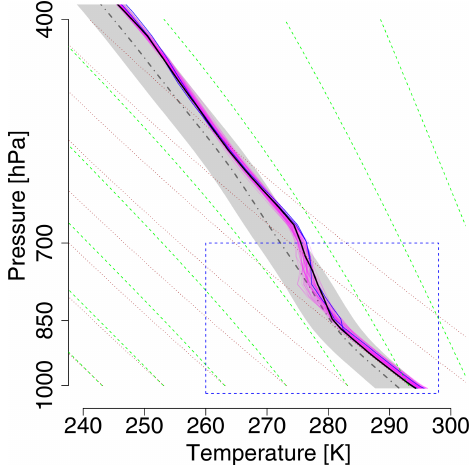
Figure 9. As in Fig. 6 but for a summer case of 2 June 2017, 12:00Z and a lead time of + 36h.